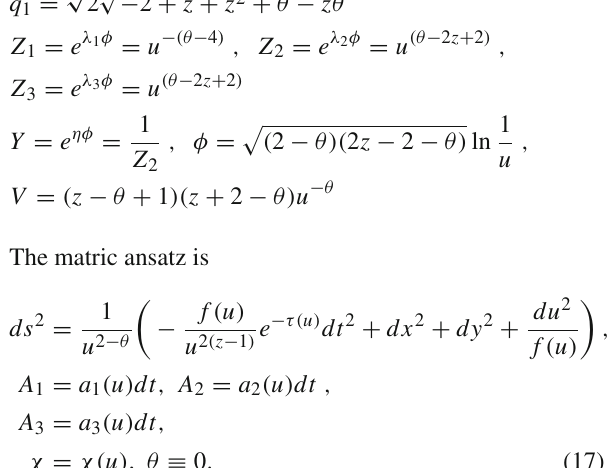
Fig. 6 Phase diagram on the temperature-doping plane with different θ and fixed z = 2 . 4. In this figure, solid lines are for ( q and dashed lines are for ( q A , q B ) = ( 0 , 1 ) . Black and red represent θ = 0 . 2 , 0 . 4, respectively. The critical temperature increases as z